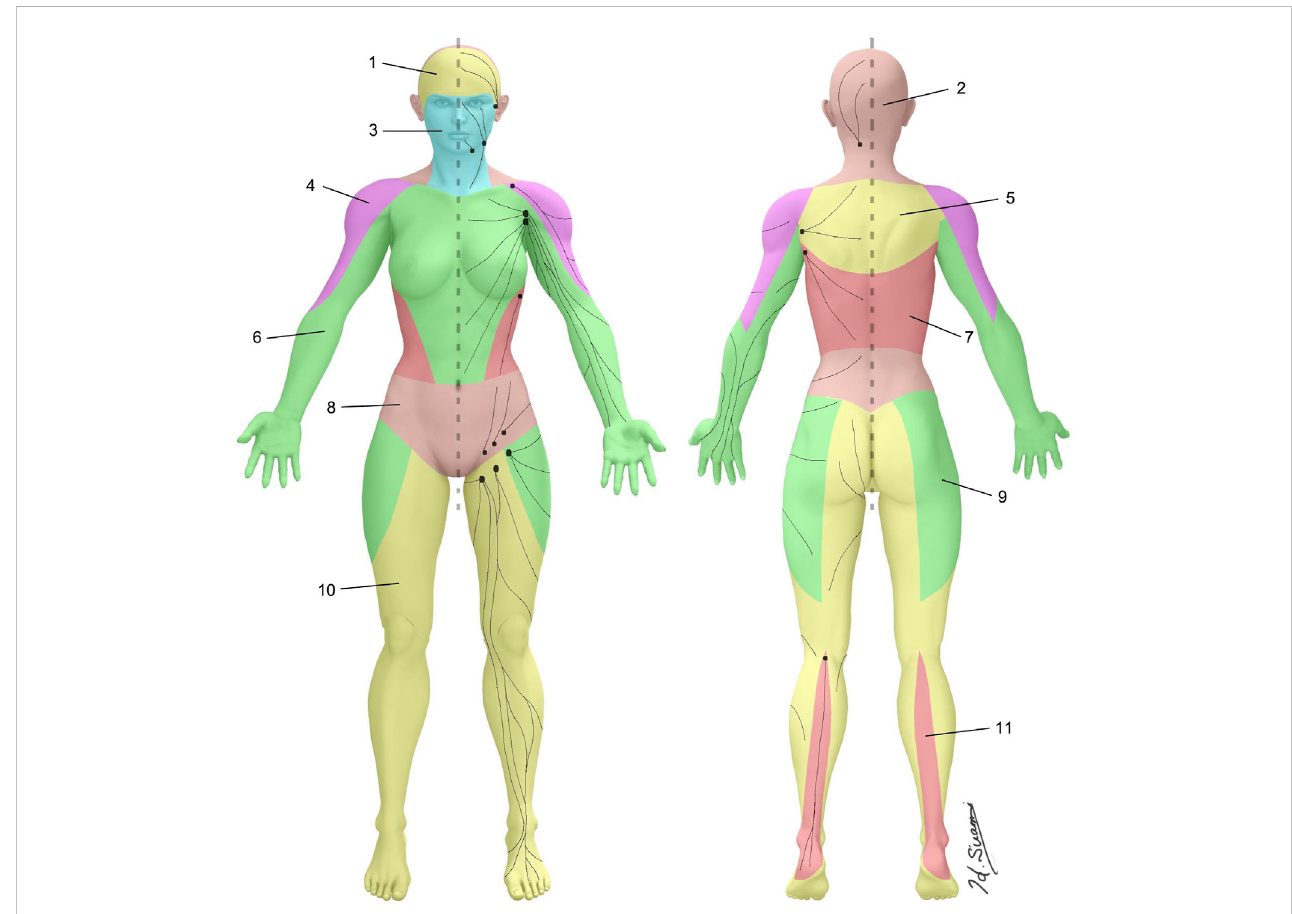
FIGURE 2 Lymphosomes of the body. The lymphatic territories are demarcated according to their corresponding lymphatic basins: 1. Temporal, 2. Occipital, 3. Super fi cial cervical, 4. Subclavicular, 5. Subscapular, 6. Lateral axillary, 7. Pectoral, 8. Superior inguinal, 9. Lateral inguinal, 10. Inferior inguinal, 11. Popliteal.